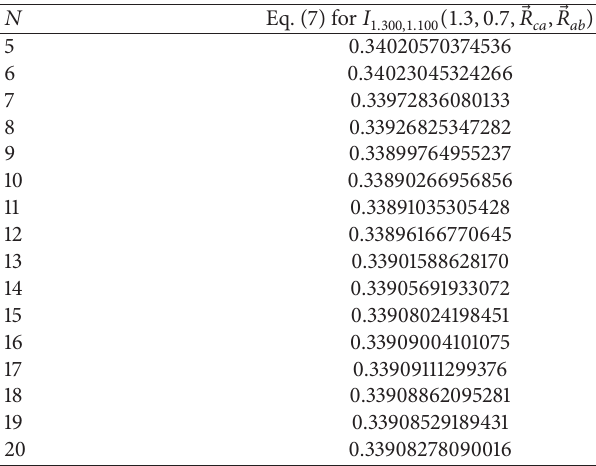
Table 3: Convergence of the series expansion relations for non- integer SF three-center nuclear attraction integrals over STOs as a function of summation limits for N . 𝑅 𝑎𝑐 = 1.8 , 𝜃 𝑎𝑐 = 30 , 𝜙 𝑎𝑐 = 60 , 𝑅 = 1.1 , 𝜃 = 60 , 𝜙 = 60 , and 𝛼 = 1 . 𝑎𝑏 𝑎𝑏 𝑎𝑏